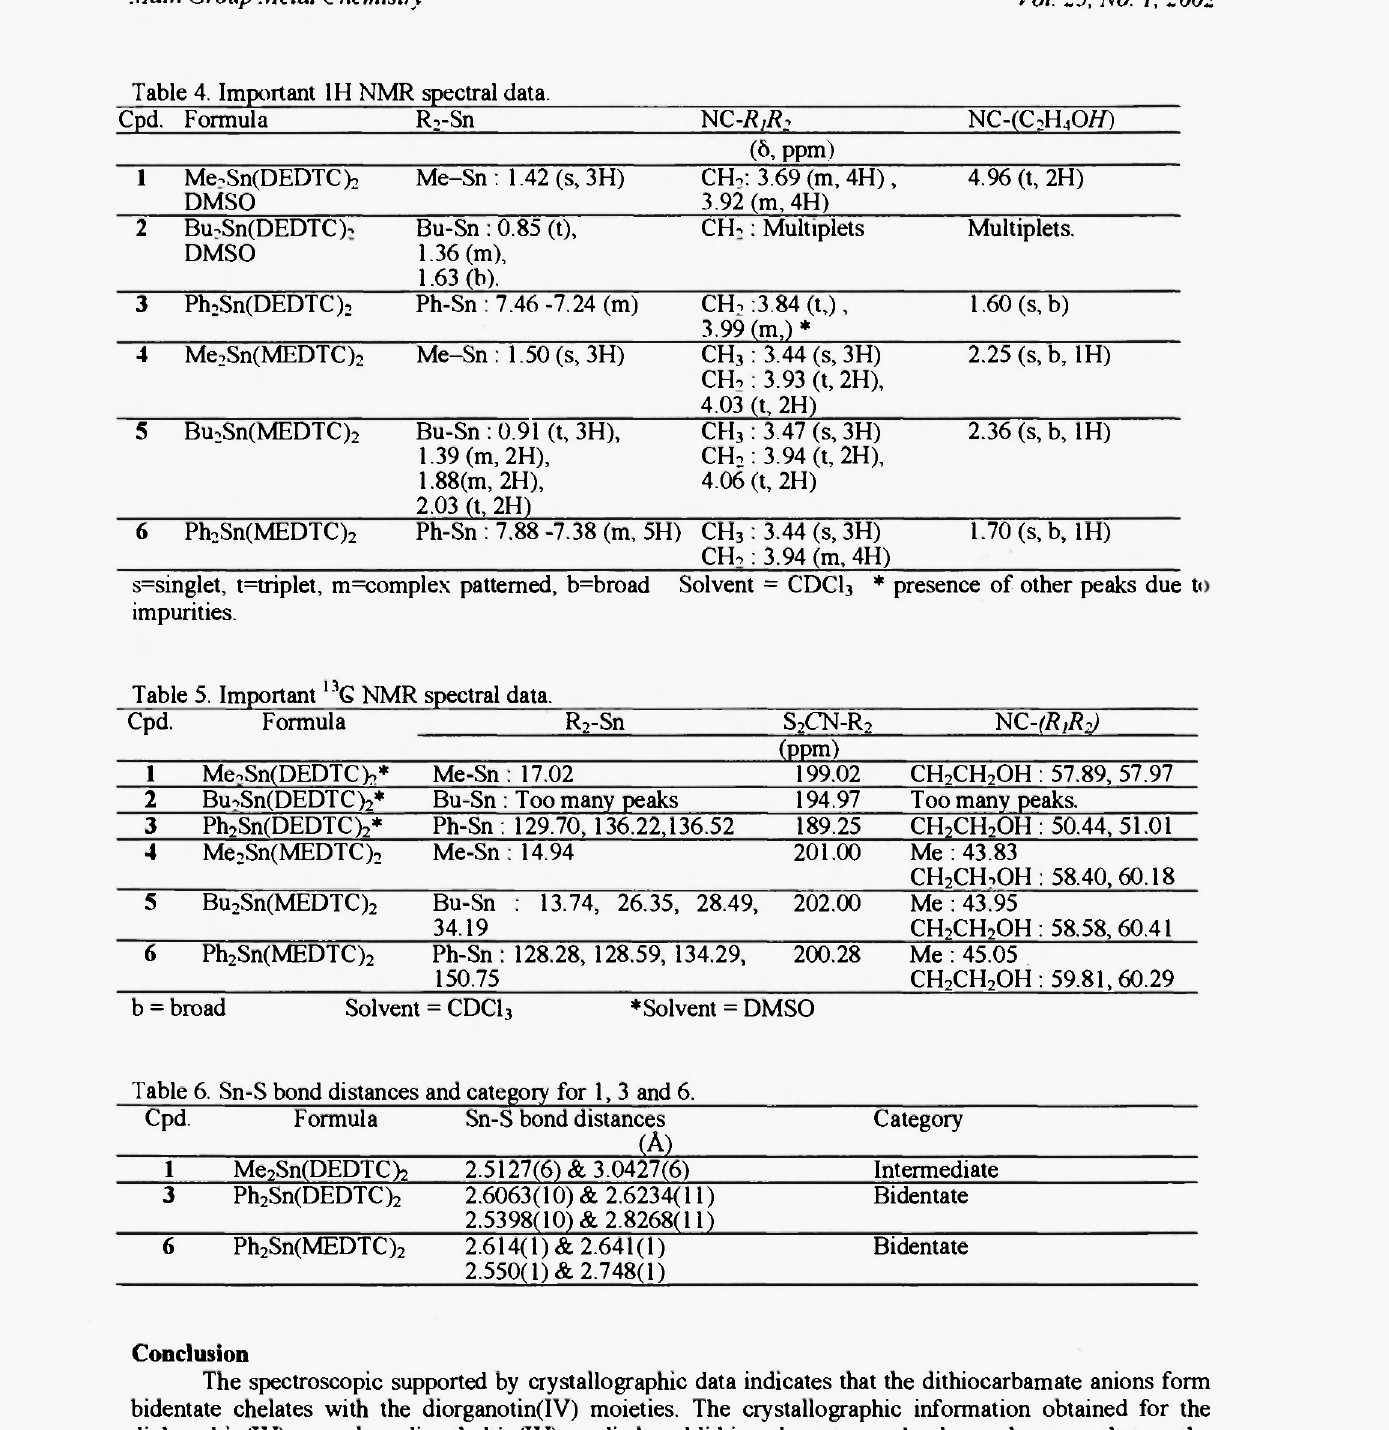
Table 4. Important 1H NMR spectral data. Cpd. Formula